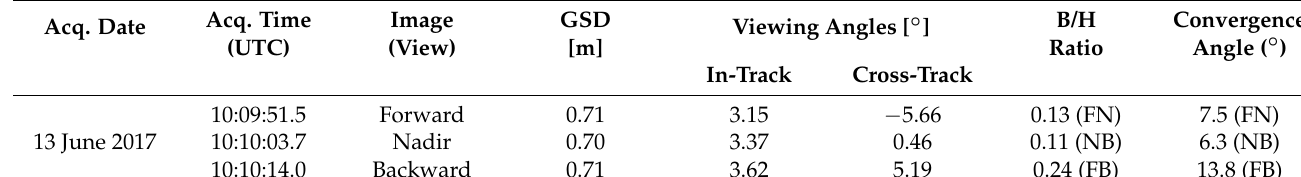
Table 1. Acquisition properties for the tri-stereo satellite image dataset over Allentsteig.